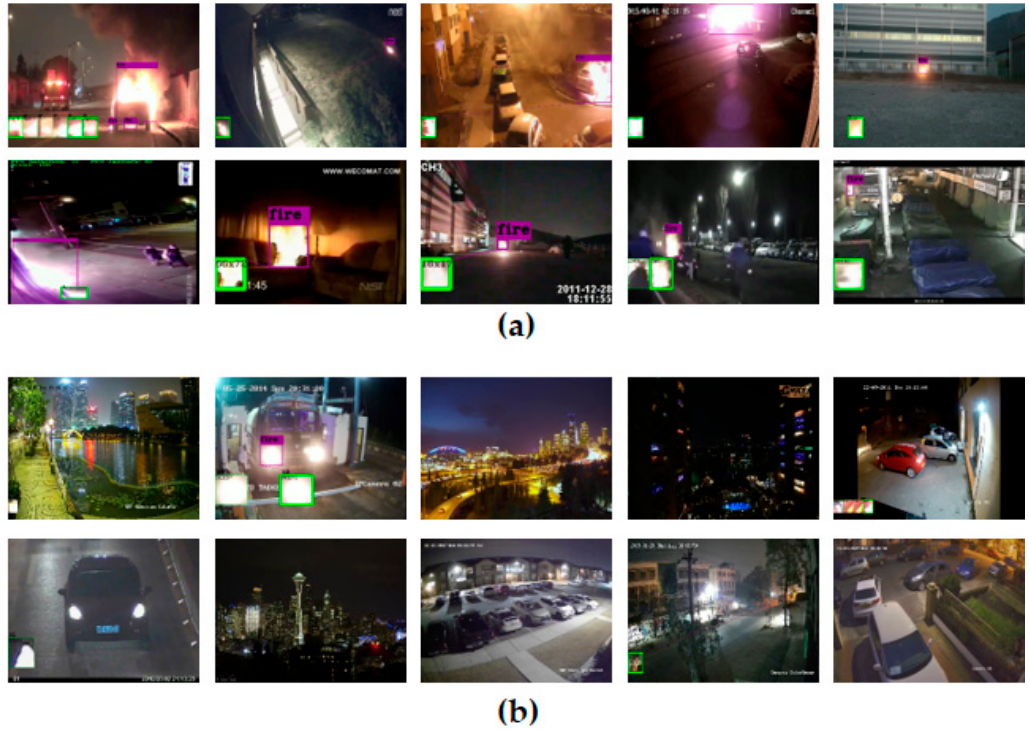
Figure 7. Fire detection results using NightFire-DB: ( a ) ten real fire videos and ( b ) ten non-fire videos. The green boxes at the bottom of the images are the candidate fire regions when using ELASTIC-YOLOv3, and the red boxes are the final results of the proposed RF when applying the fire-tube method.